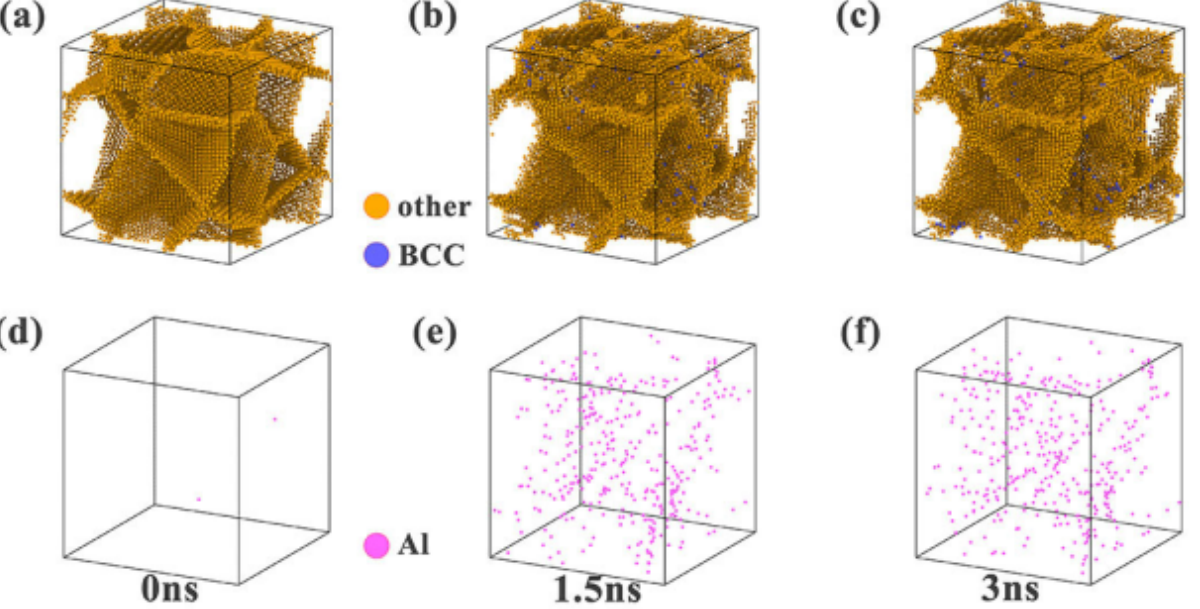
Figure 5. Element segregation process ( a – c ) and Distribution of Al elements ( d – f ) of the CrCoNiAl 0.014 alloy with medium-entropy at 0, 1.5 and 3 ns grain boundaries, respectively, at 300